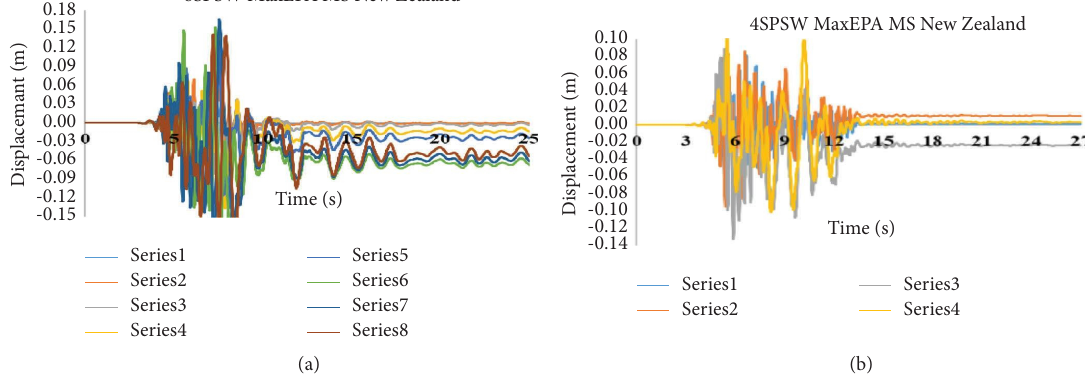
Figure 9: Time history of the displacement response under New Zealand MS: (a) 4-story model, (b) 8-story model. Table 15: Results of peak maximum interstory drift demand of models in the MS and SS Group I.